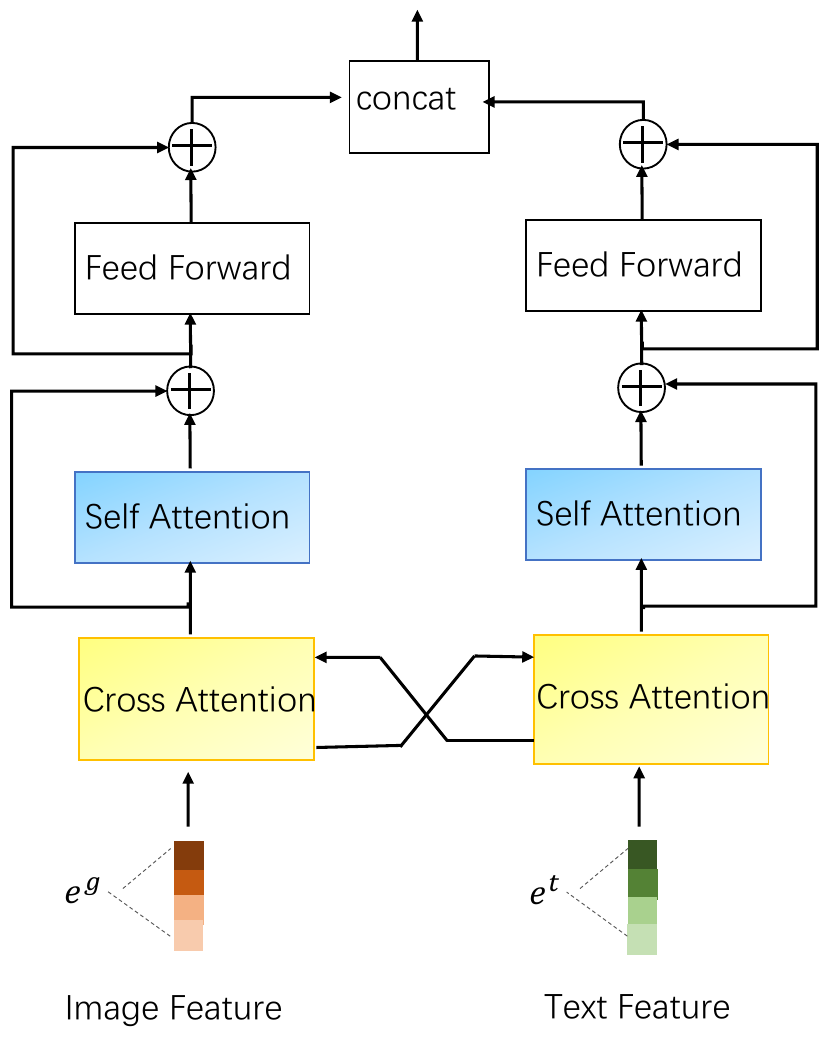
Figure 3. Illustration of the Cross-modal Fusion